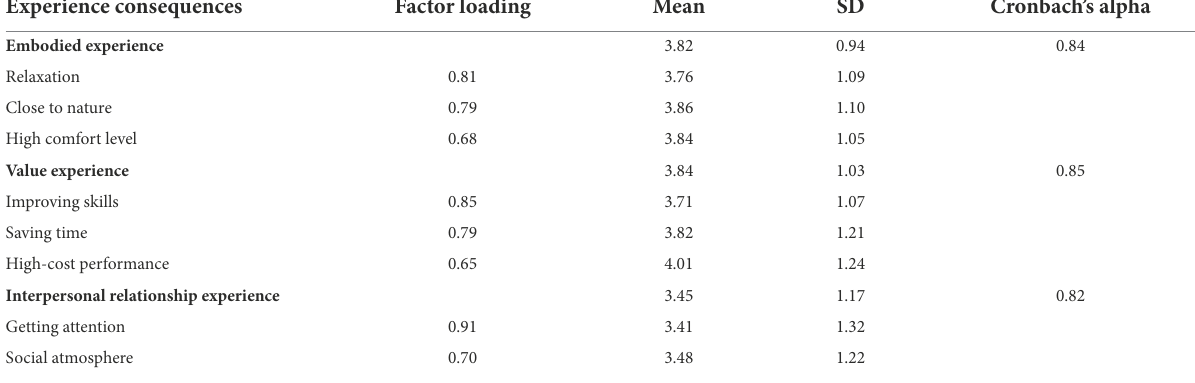
TABLE 4 Factor loading of experience consequences.